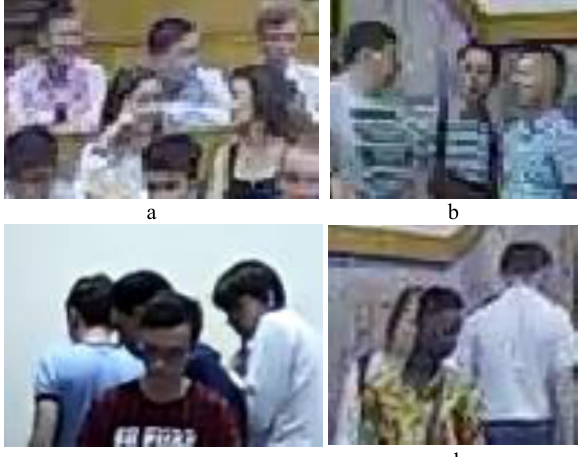
Figure 1. Examples of low-quality images for human head detection